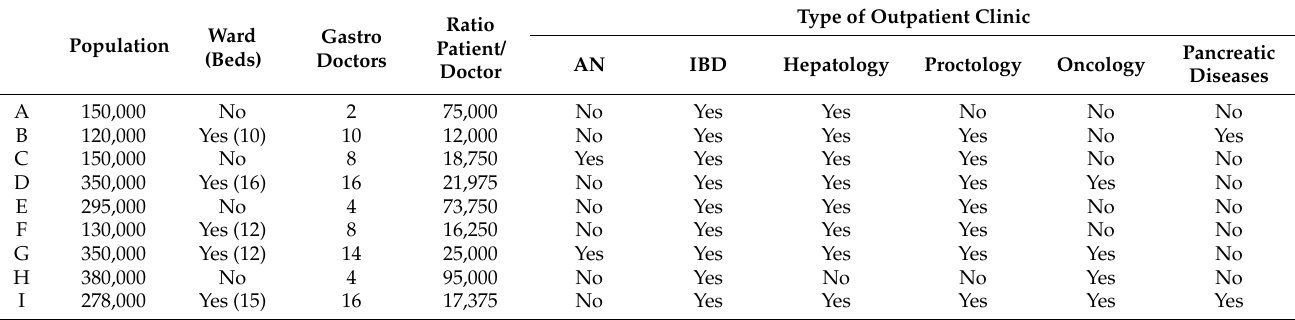
Table 1. Department characterization in